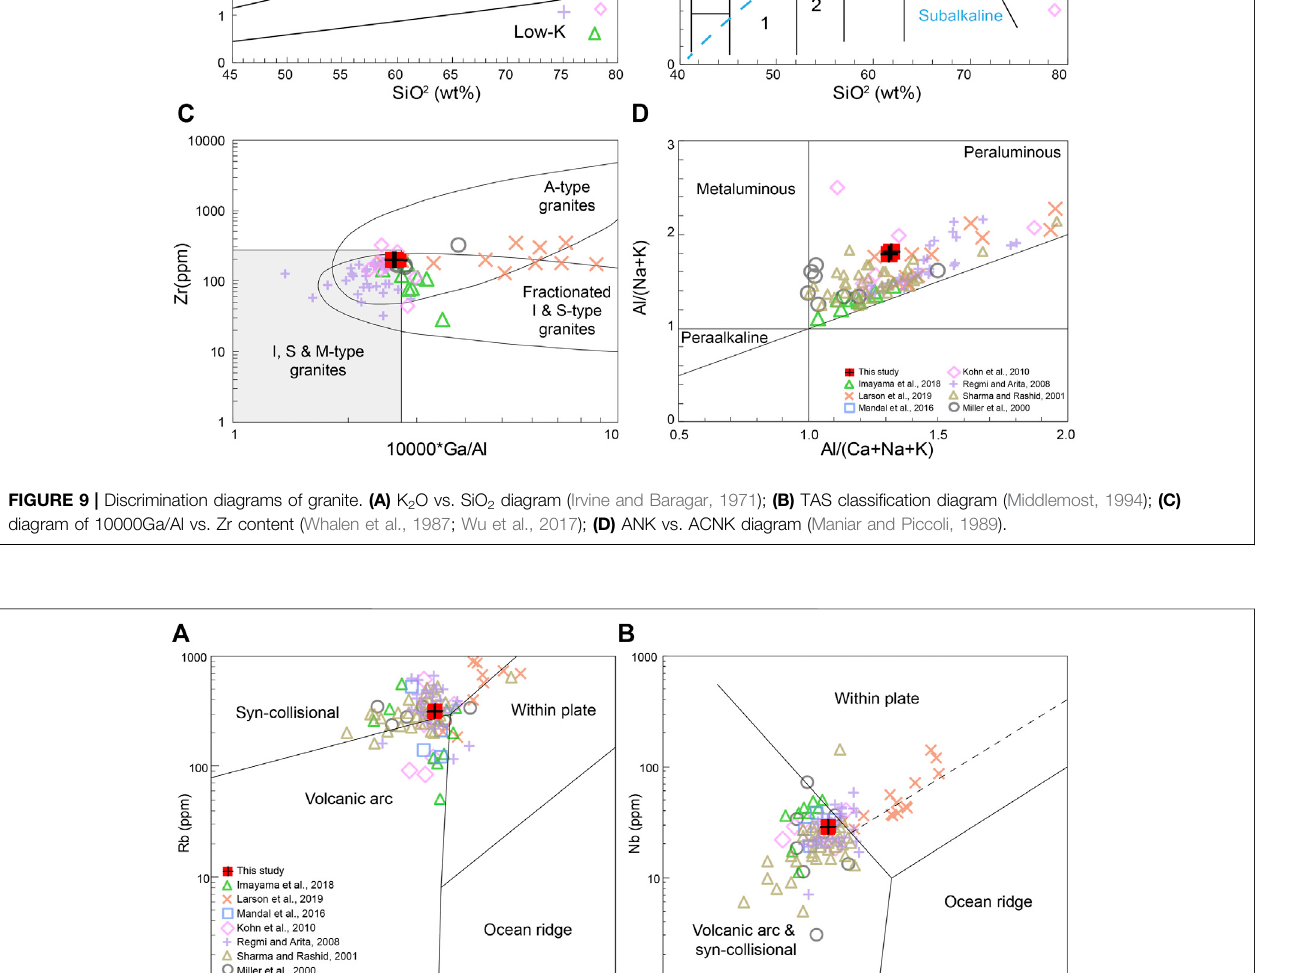
discrimination diagram of Rb vs. (Y + Nb) of Pearce (1996),